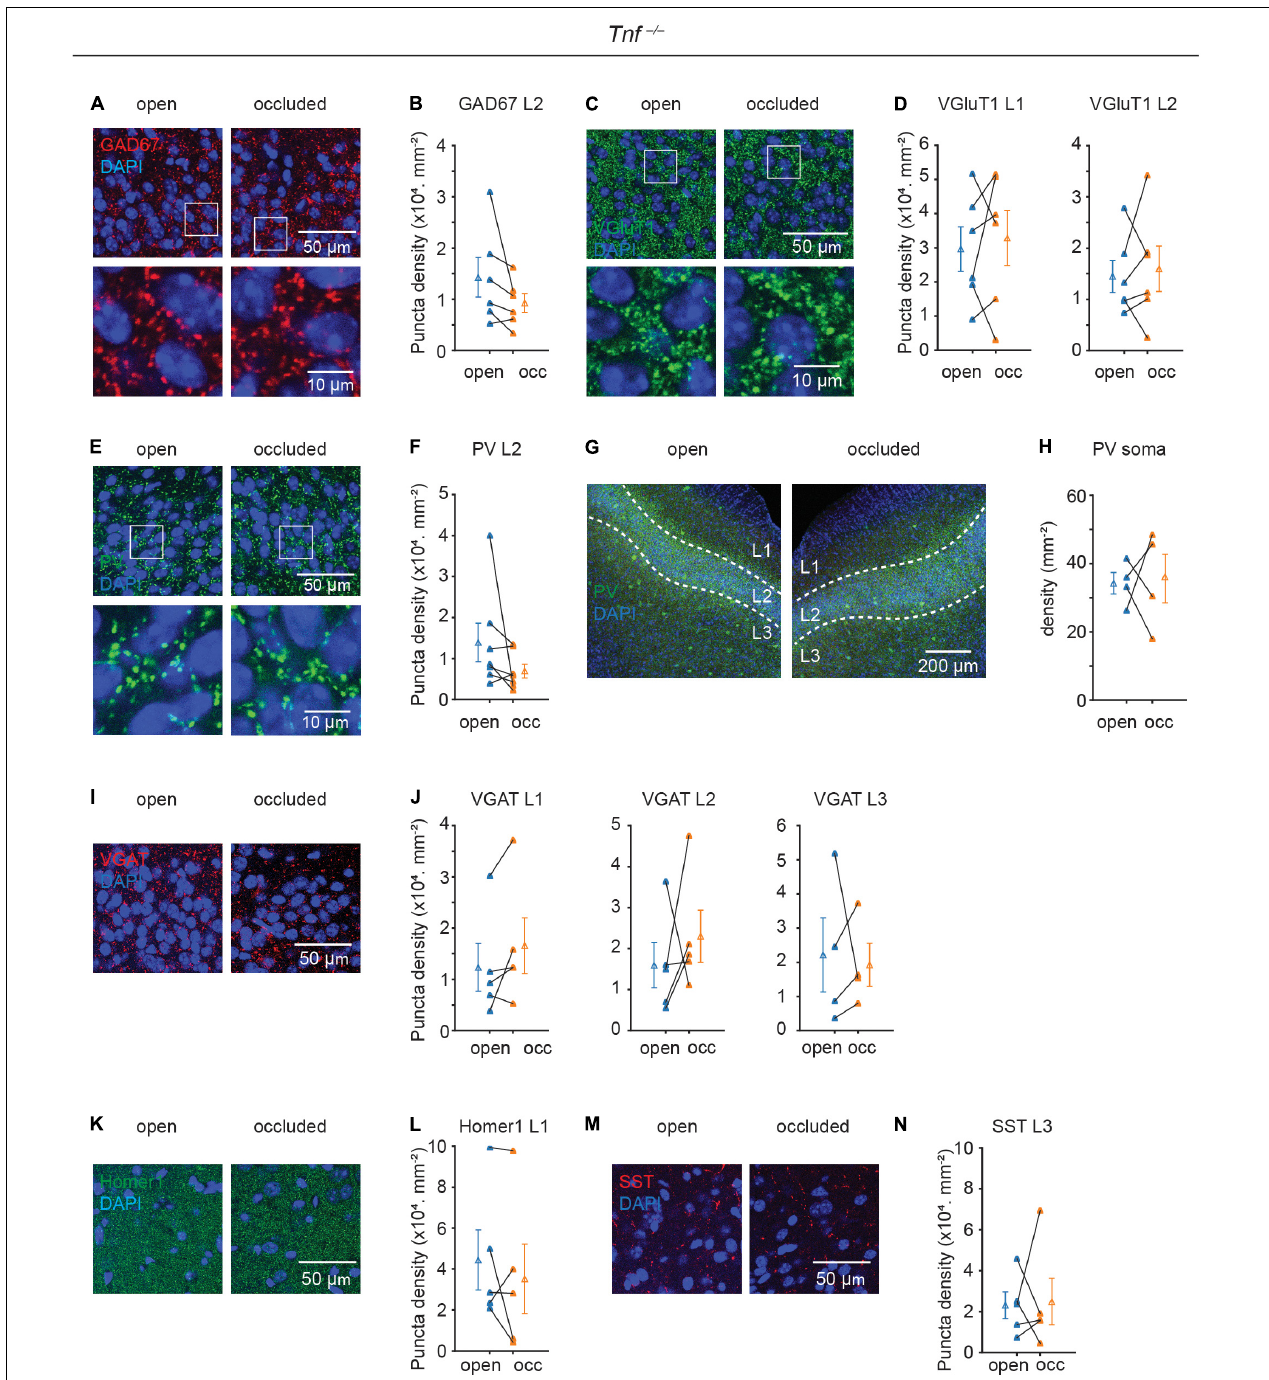
FIGURE 4 | Plasticity of excitatory and inhibitory synapses induced by sensory deprivation is abolished in Tnf − / − mice. (A) Representative images of GAD67 puncta in layer 2 of APC. (B) Quantification of GAD67 puncta density in layer 2 of APC. ( p = 0.148, N = 6) (C) representative images of VGluT1 puncta in layer 2 of APC. (D) Quantification of VGluT1 puncta density in layer 1 and layer 2 of APC. (L1: p = 0.661, N = 6; L2: p = 0.703, N = 6) (E) Representative images of PV puncta in layer 2 side of APC. (F) Quantification of PV puncta density in layer 2 of APC. ( p = 0.156, N = 7) (G) representative images of PV neuron in APC. (H) Quantification of PV neuron density in APC. ( p = 0.885, N = 4) (I) representative images of VGAT puncta in layer 2 of APC. (J) Quantification of VGAT puncta density in layer 2 of APC (L1: p = 0.15, N = 5; L2: p = 0.5, N = 5; L3: p = 0.81, N = 5). (K) Representative images of Homer1 puncta in layer 1 of APC. (L) Quantification of Homer1 puncta density in layer 1 of APC ( p = 0.41, N = 5). (M) Representative images of SST puncta in layer 3 of APC. (N) Quantification of SST puncta density in layer 3 of APC ( p = 0.89, N = 5). n = 2 – 3 repeats of experiments were performed. Mann-Whitney test was used for PV puncta density in L2. Paired t -test was used for the rest of the datasets.